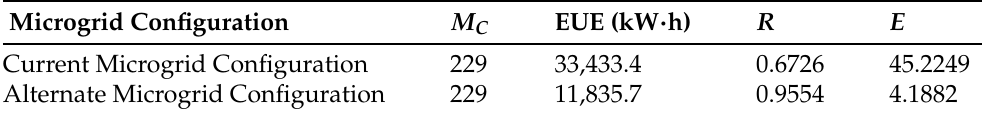
Table 5. Summary of current and alternate microgrid configurations from data presented in Tables 3 and 4. The reduced E of the alternate microgrid configuration indicates it is more resilient than the current microgrid configuration in the failure scenarios